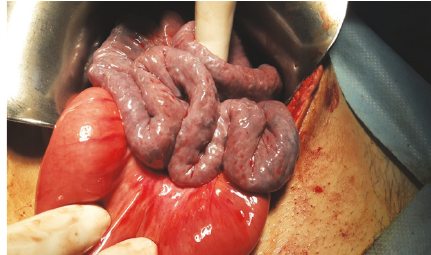
Figure 1: Axial contrast enhanced CT showing characteristic whirlpool sign. The structure between the two arrows shows whirlpool sign.